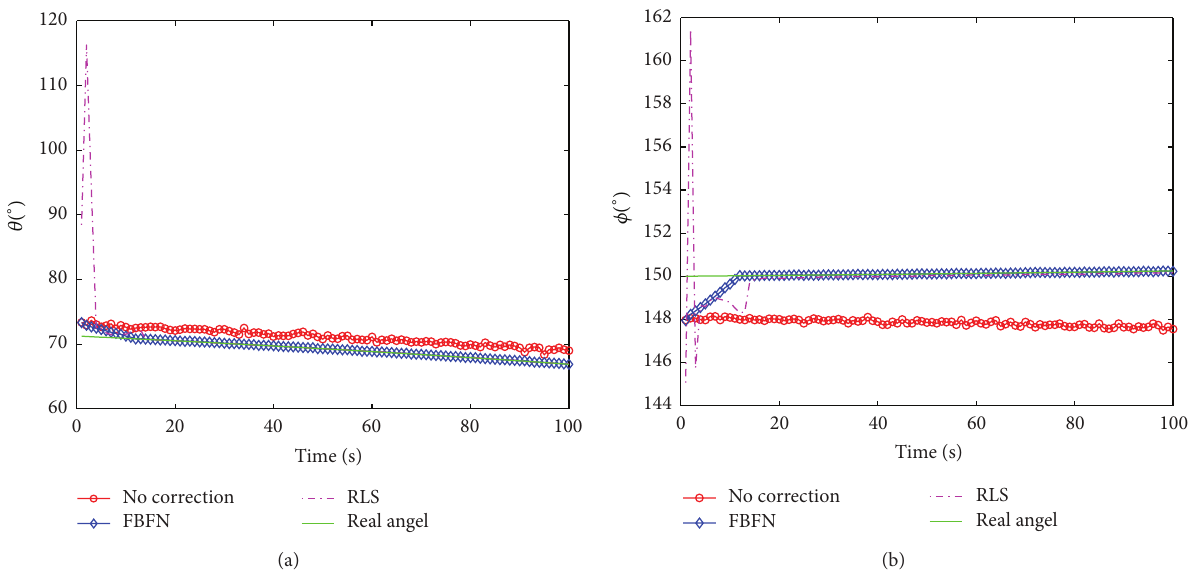
Figure 10: (a) Elevation and (b) horizontal beam pointing error compensation for linear moving target.